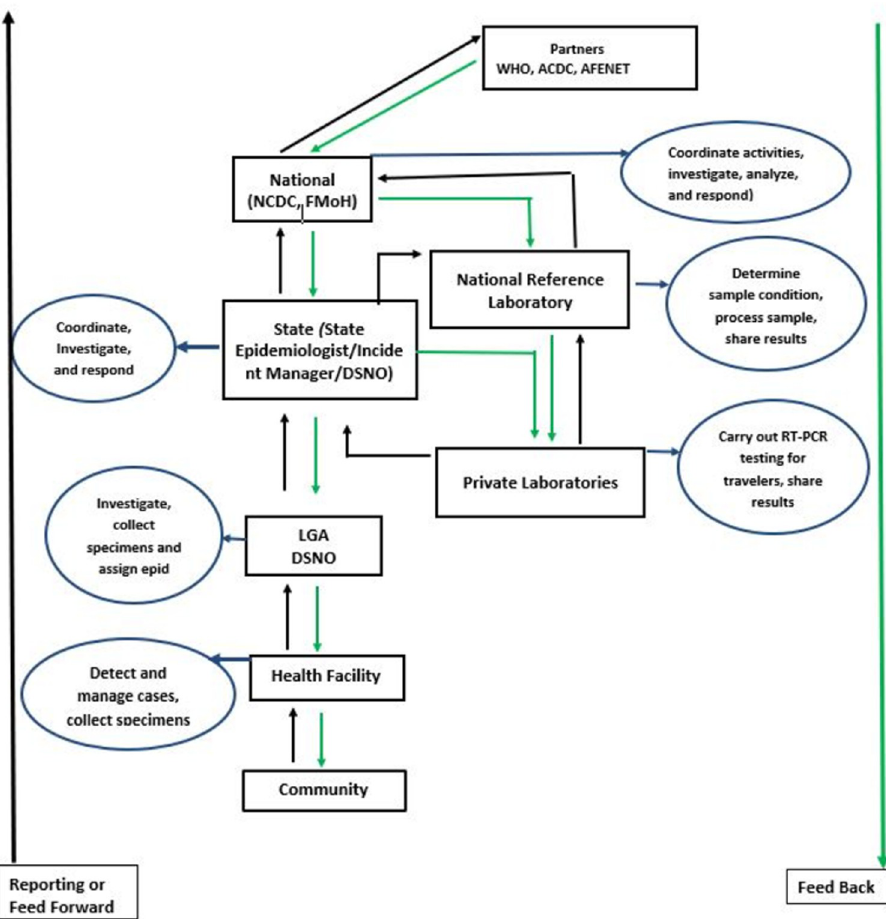
Fig 1. Information flow in FCT COVID-19 surveillance